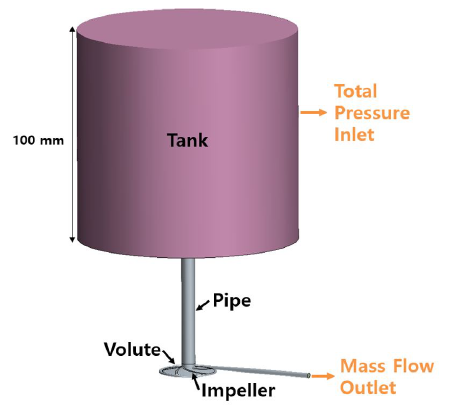
Figure 8. CFD domain.